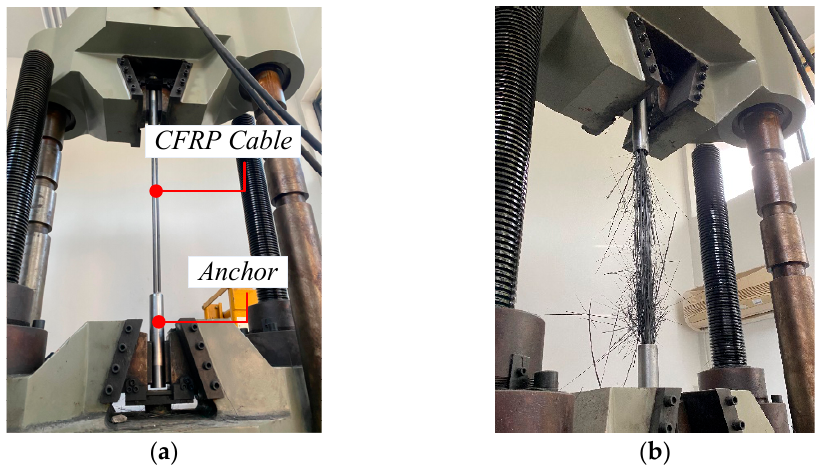
Figure 5. ( a ) Installation, ( b ) Failure. Static load test on the CFRP cable. Table 2. Static load test data of the CFRP cable.